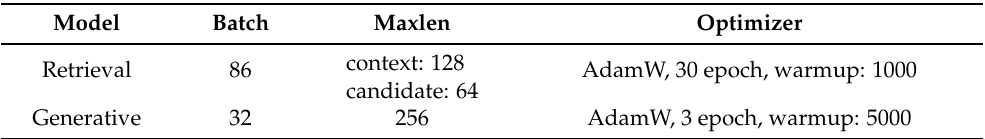
Table 2. Parameters for training the retrieval and generative